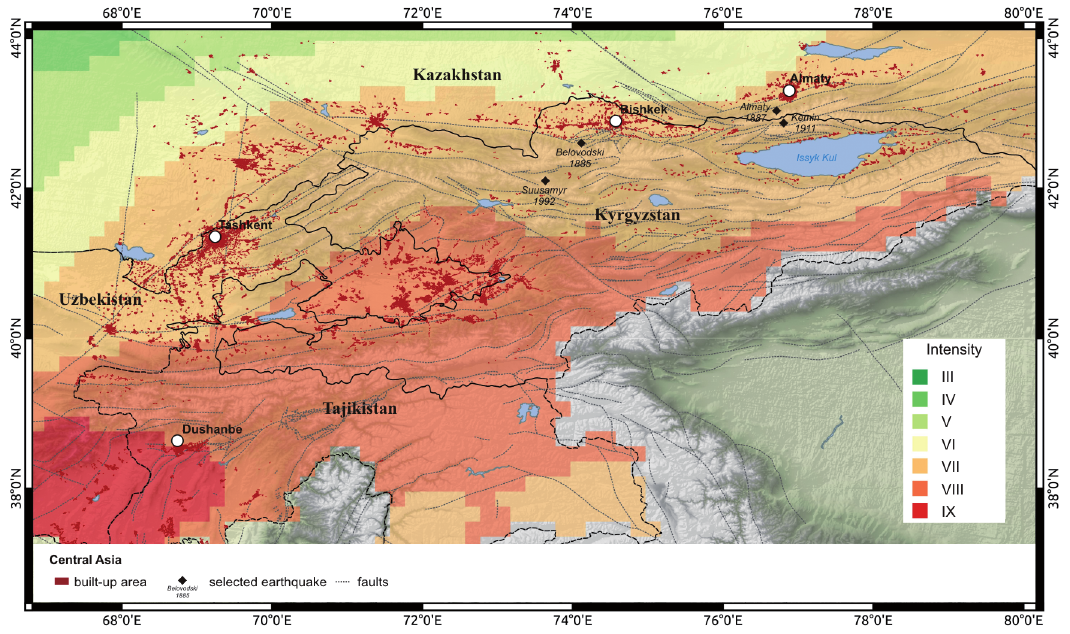
Figure 1. The study area of Central Asia with settlement extents extracted from satellite images, locations of major earthquakes and seis- mic hazard from a smoothed seismicity